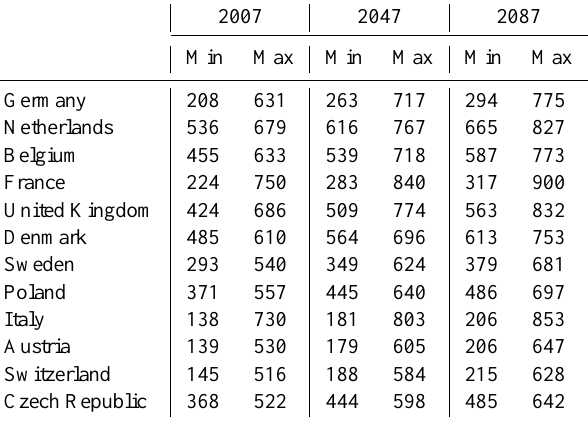
Table 1. National maximum and minimum annual ammonia emis- sion from the standard pig storage facility from the gridded calcu- lations. Note that minimum numbers for Austria, Italy and Switzer- land should be treated with caution due to the dependency of the meteorological data set that was used in the